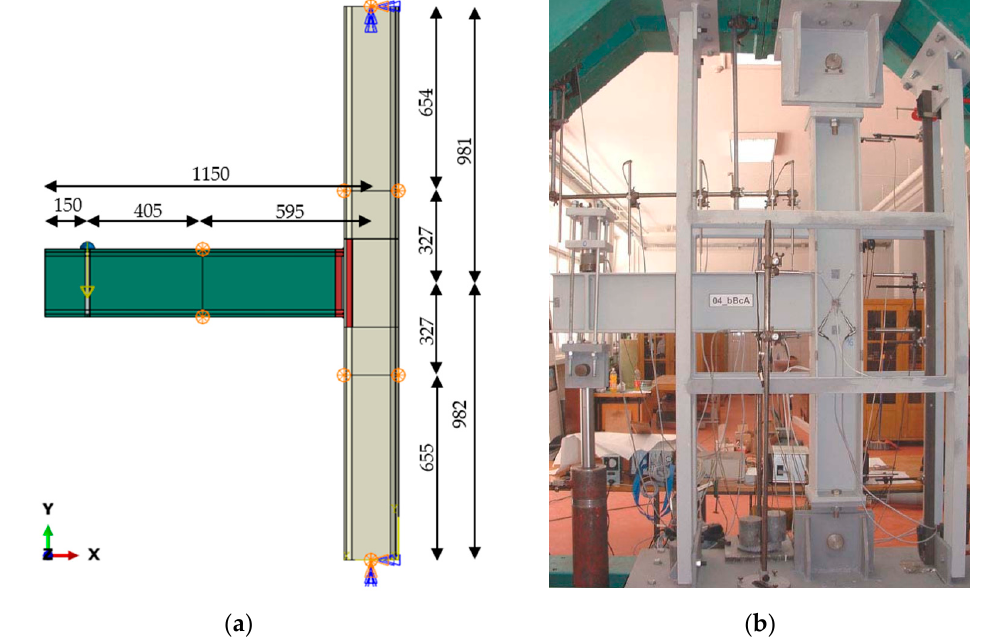
Figure 6. Welded beam-to-column joint set-up: ( a ) Numerical model (axial dimensions, units in mm); ( b ) Experimental set-up [27].